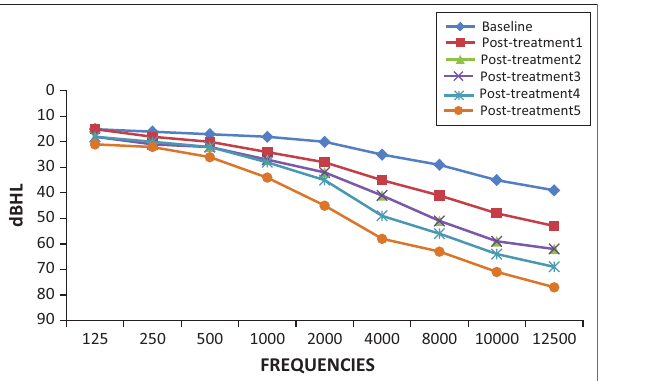
FIGURE 3: Pure tone audiometry mean thresholds over treatment duration: Left ear. FIGURE 2: Pure tone audiometry mean thresholds over treatment duration: Right ear.